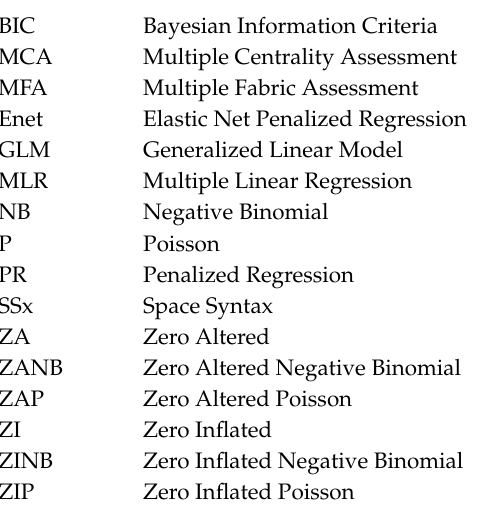
papers investigating the relationship between urban form (mainly street-network configuration properties) and micro-retail